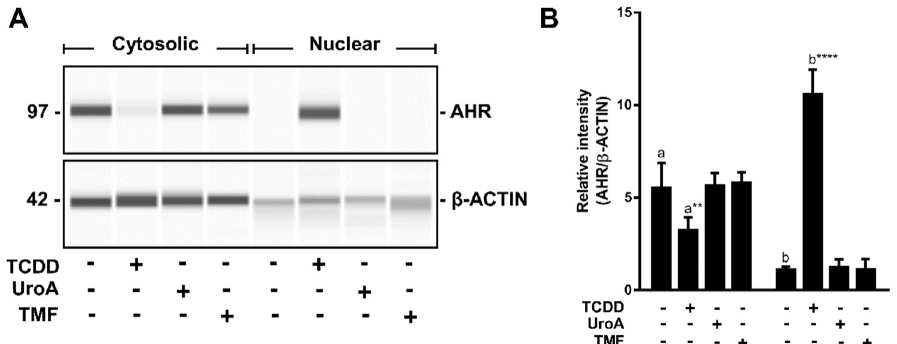
Figure 9. AHR is not retained in the nucleus upon UroA treatment. ( A ) HepG2 (40/6) cells were treated for 1 h with 10 nM TCDD, 10 µM UroA or 10 µM TMF as indicated. AHR protein levels were assessed by Western blot on cytosolic or nuclear extracts; and ( B ) quantification of the immunoblot determined using a ProteinSimple Wes system. Data are presented as mean +/−S.E.M., n = 3; significance was determined by one-way ANOVA, p -value ≤ 0.01 (**) or p -value ≤ 0.0001 (****).